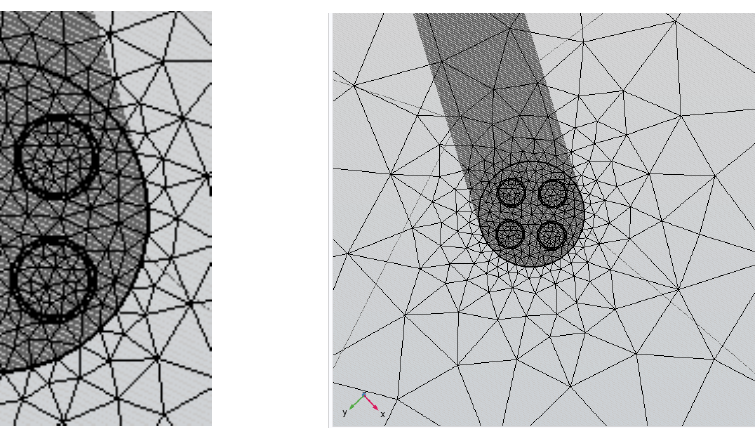
Figure 2.a. Grout and U-tube Meshing Figure 2.b. Soil Meshing Figure 2. Borehole geometry